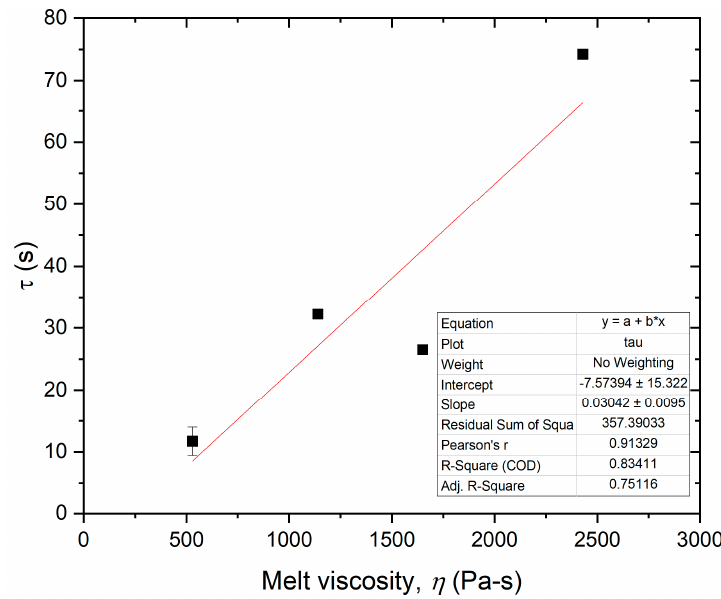
Figure A2. Fitting results between characteristic conductivity growth duration and melt viscosity of